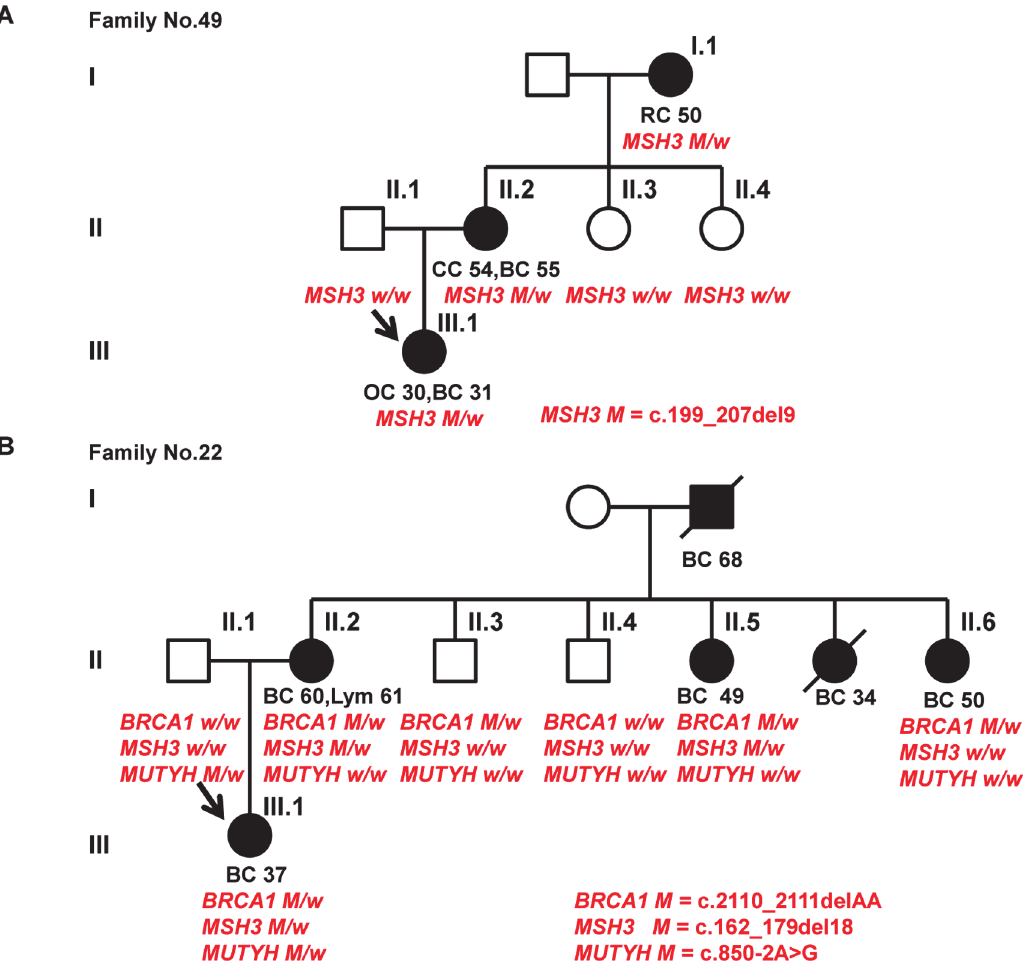
Fig 5. Pedigrees and results of segregation studies of family No. 49 and family No. 22. Subjects with cancers are indicated with solid symbols. Sites of cancer are breast (BC), ovary (OC), rectum (RC), colon (CC), and lymphoma (Lym). Ages under symbols indicate age at cancer diagnosis. Probands are indicated with arrows. Individuals having the gene mutation were indicated as M/w , and those not having such gene mutation were indicated as w/w . A, the pedigree and results of segregation analysis of family No. 49. B, the pedigree and results of segregation analysis of family No. 22.